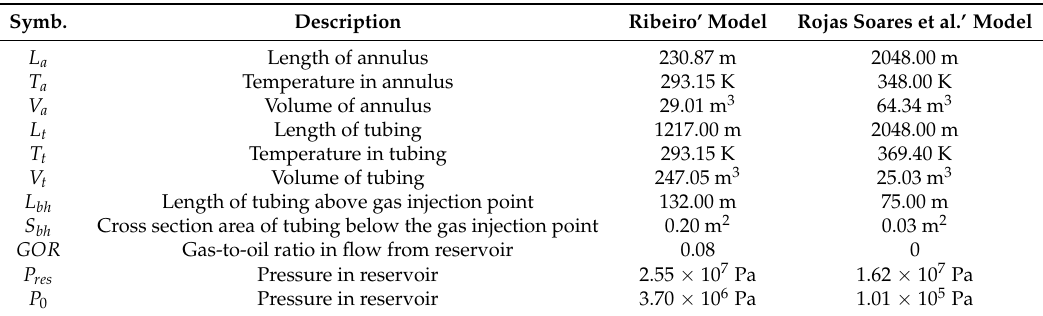
Table 2. Well/Reservoir parameters used in simulations.